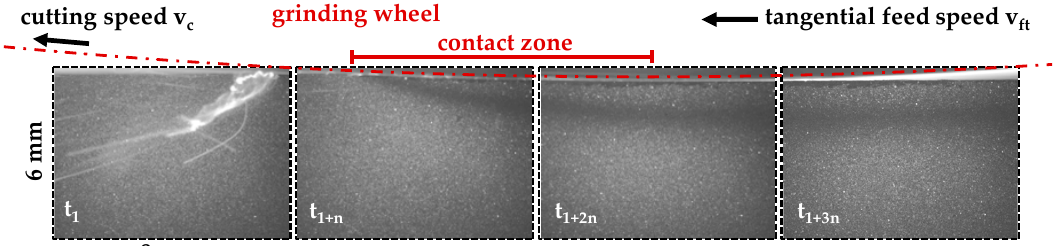
Figure 5. Sequence of individual speckle images, to reconstruct a large field of view of 6 mm × 32 mm.